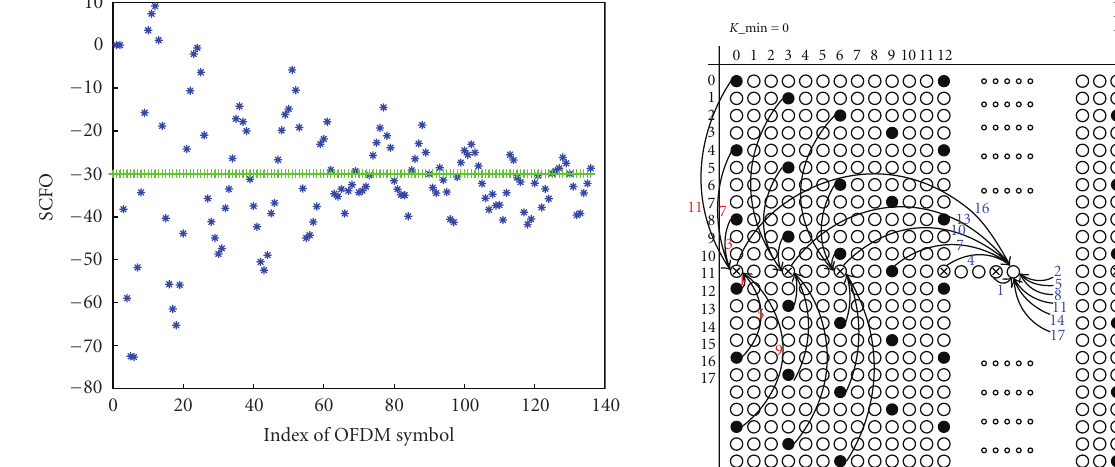
Figure 2: Typical behavior of the implemented SCFO tracking algorithm for SCFO = 30 ppm. (“+” = actual SCFO, “ ∗ ” = SCFO estimated by the tracking algorithm).